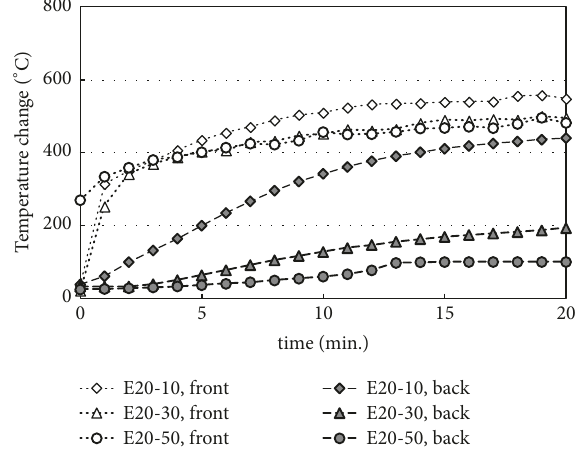
Figure 8: Relation between unit polymer content in PCM and total heat release amount.